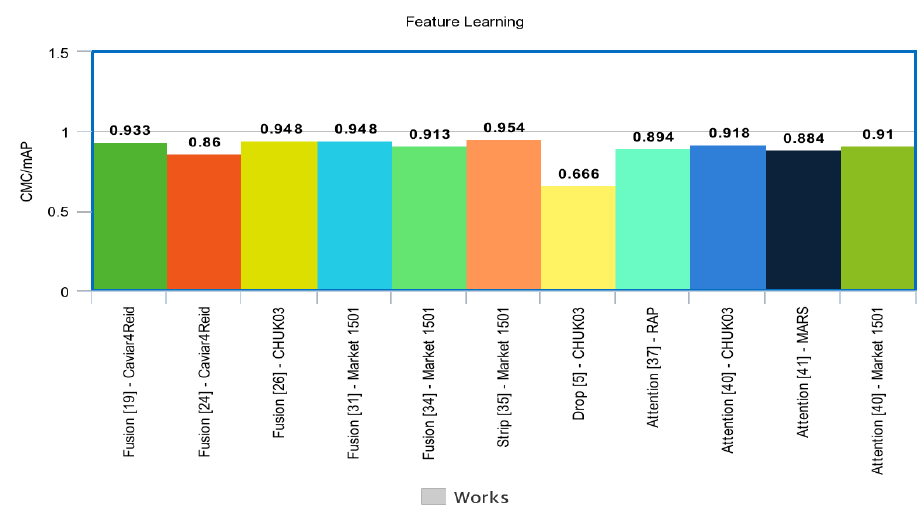
Figure 5. Performance summary of the evaluated feature learning